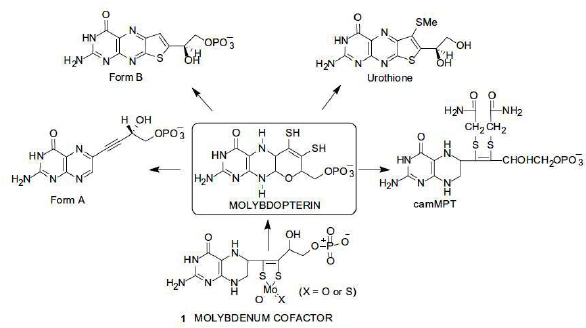
Figure 11: Molybdenum cofactor and its different pterin metabolites isolated from human